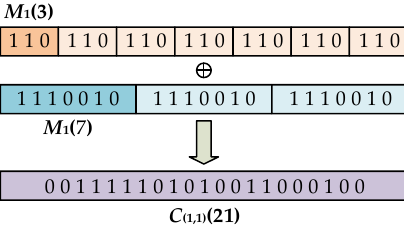
Figure 1. Construction of a composite maximal-length sequence (CMLS) with a length of 21 based on two maximal-length sequence (MLS) codes with a length of 3 and 7.